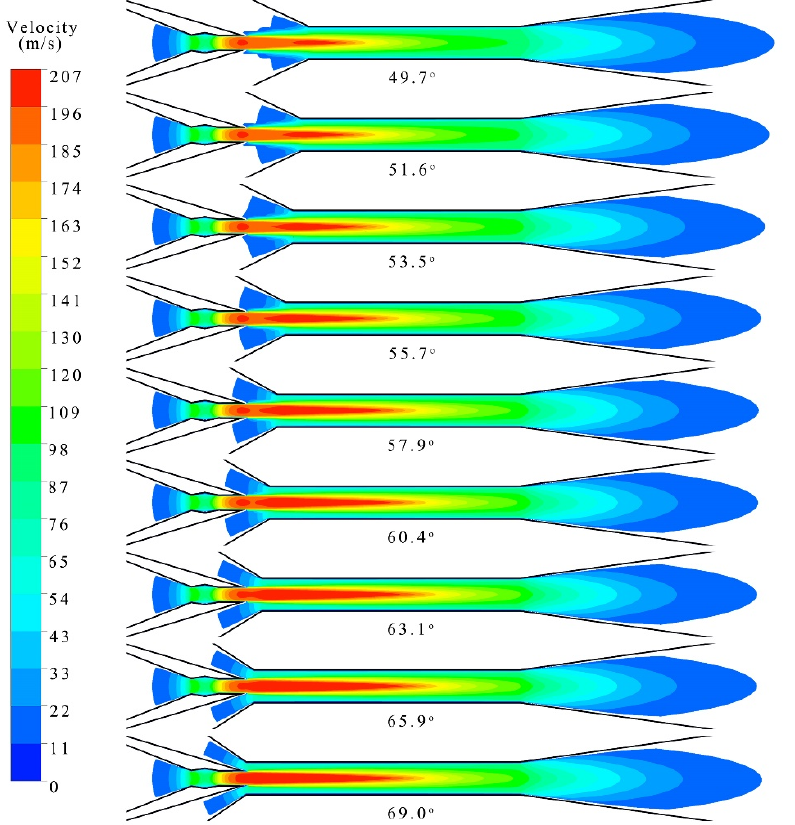
Figure 15. Fields of velocity under different θ pm ( P p of 9.3 MPa).